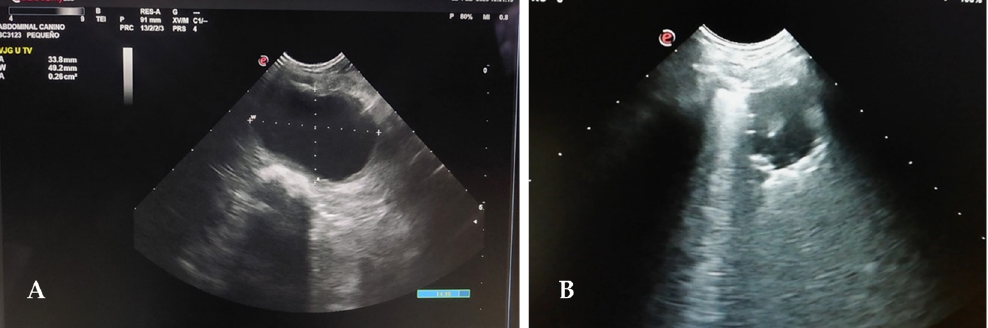
Figure 7 . Veterinary point-of-care ultrasound (POCUS). ( A ) Abdominal POCUS screening of a bladder for urinary retention and sediment control. ( B ) Thoracic POCUS showing a consolidation in a dog with pulmonary atelectasis.